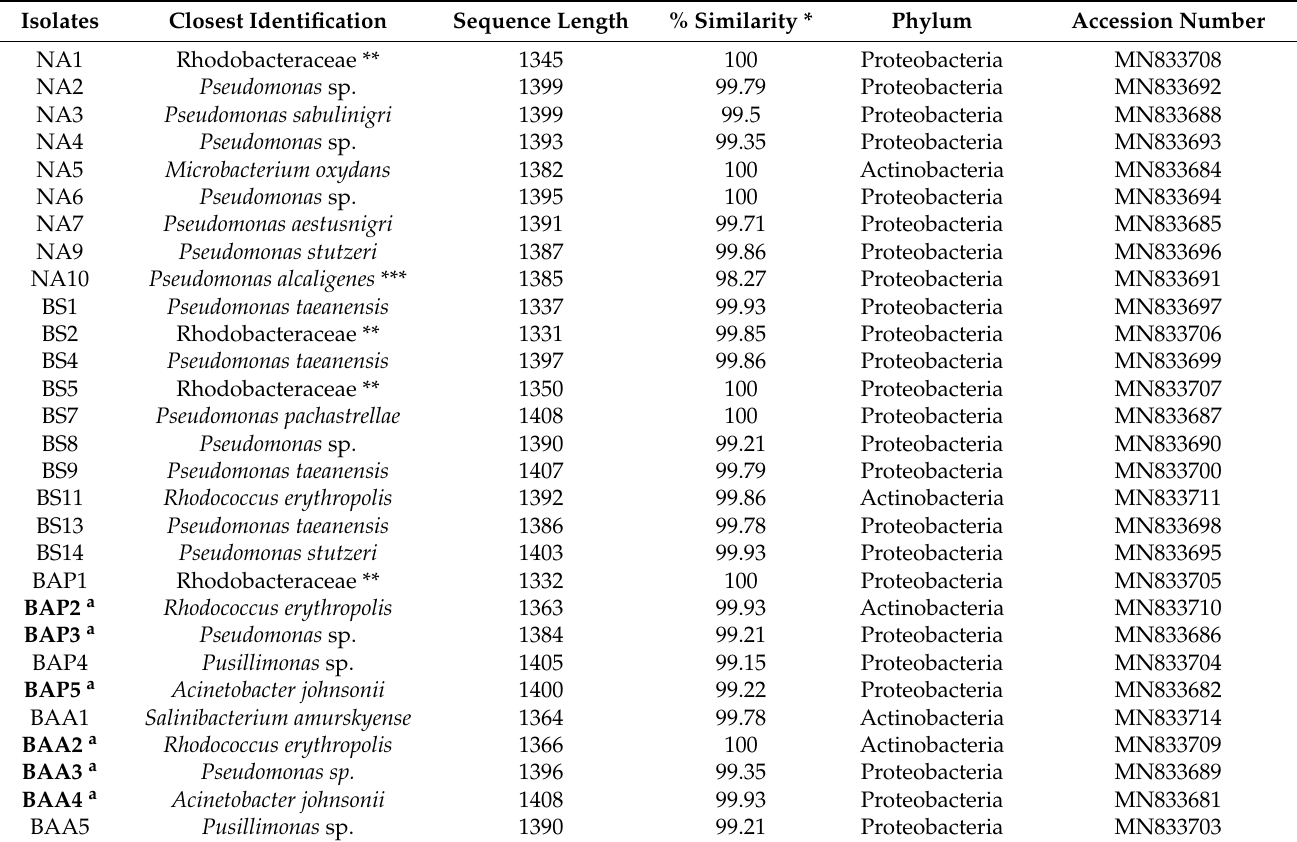
Table 2. Phylogenetic identification of bacterial strains isolated at the end of the microcosms bioremediation experiment for the different treatments: natural attenuation (NA), biostimulation (BS), bioaugmentation with inoculum pre-grown in petroleum (BA/P) and bioaugmentation with inoculum pre-grown in acetate (BA/A). In bold isolate similar to the bacterial strains (CPN1-CPN5) used as inocula for the bioaugmentation